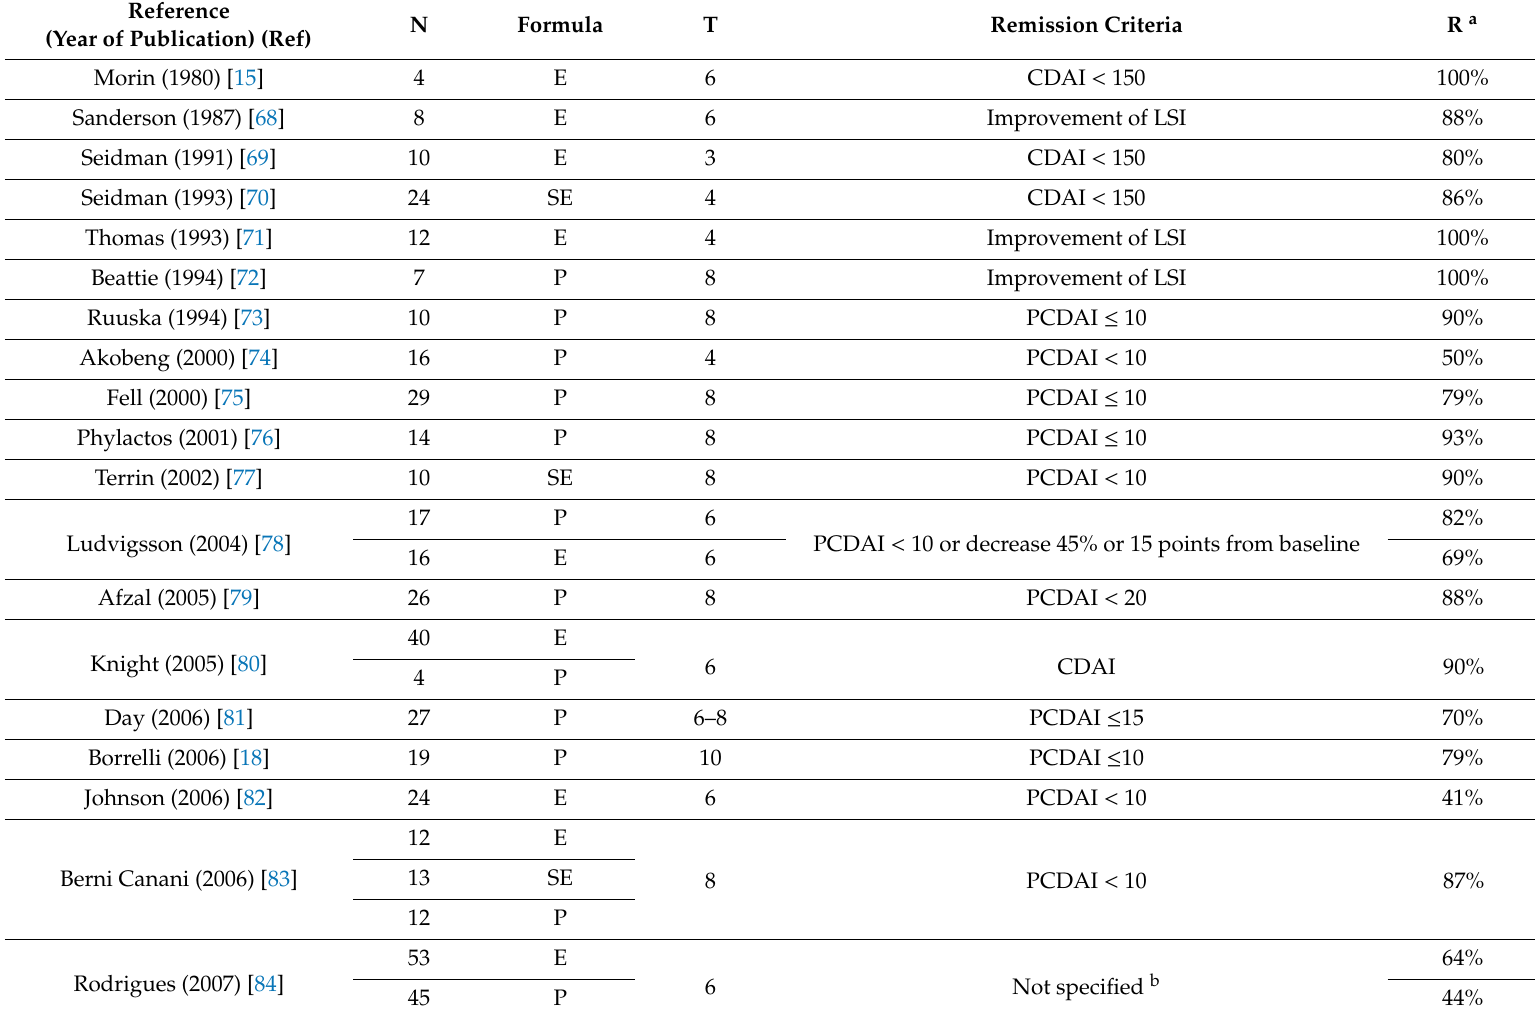
Table 3. Clinical remission rates in children with Crohn’s Disease (CD) treated with Exclusive Enteral Nutrition